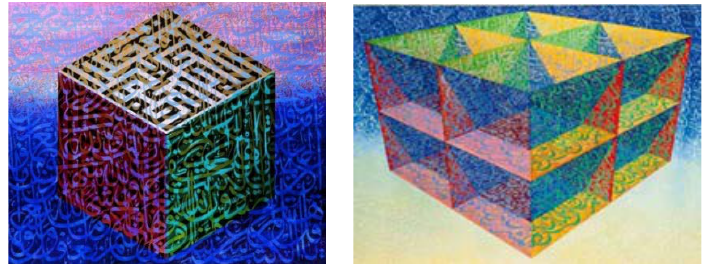
Figure 12-1 Ahmed Mustafa’s painting